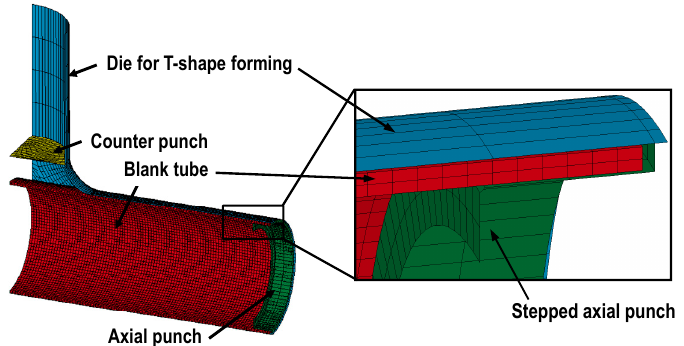
Figure 6. FE model for warm T-shape hydroforming.